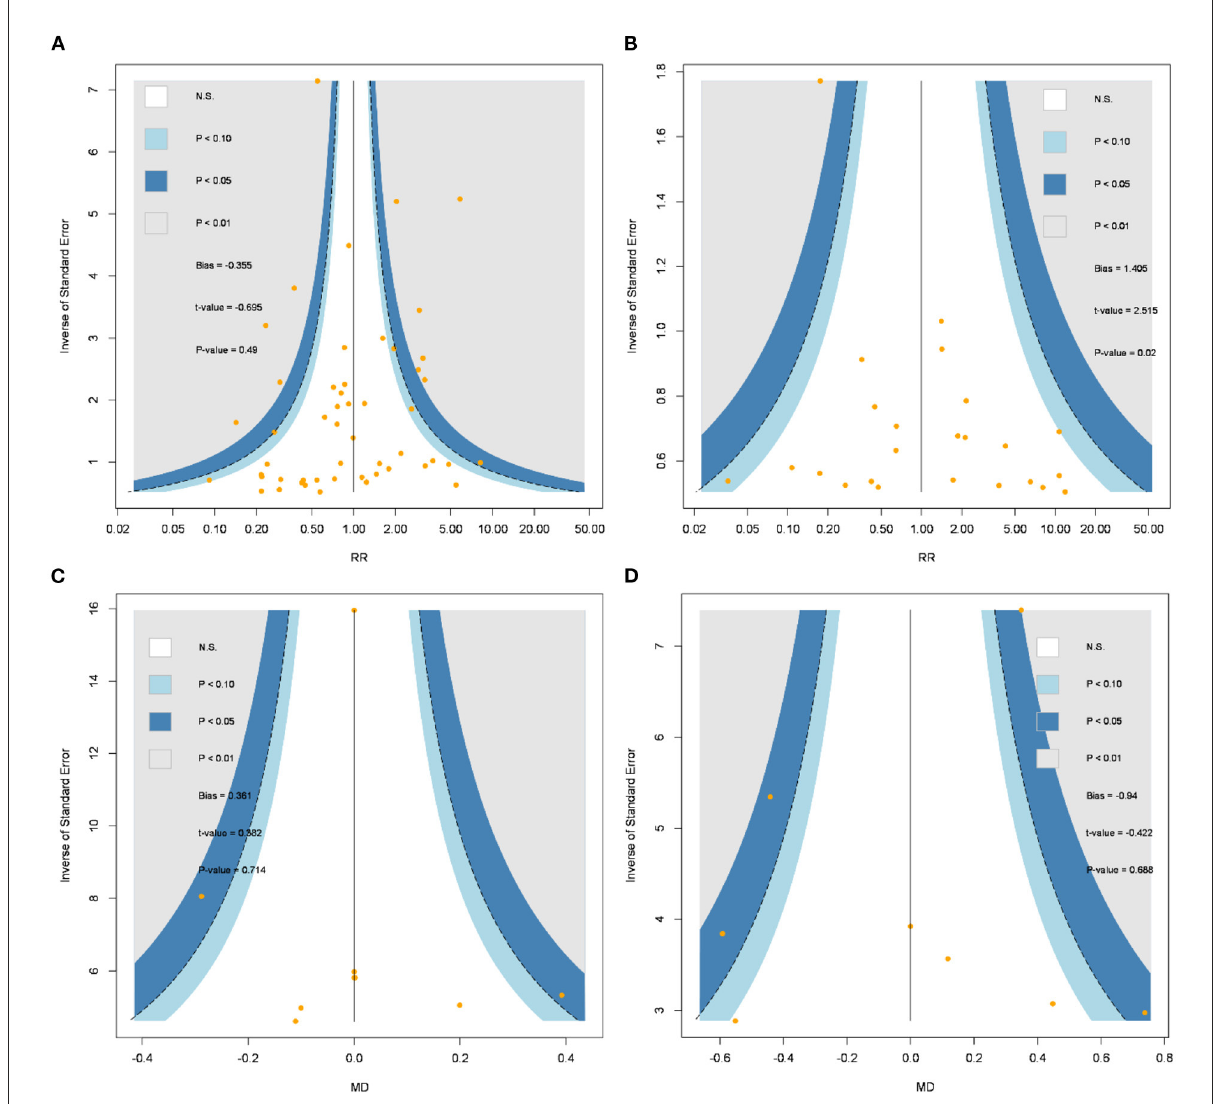
FIGURE4 Comparison-adjusted funnel plots of (A) intraoperative floppy iris syndrome, (B) severe intraoperative floppy iris syndrome, (C) mesopic pupil diameter, (D) dilated pupil diameter. MD, mean difference; N.S., non-significance; RR, risk